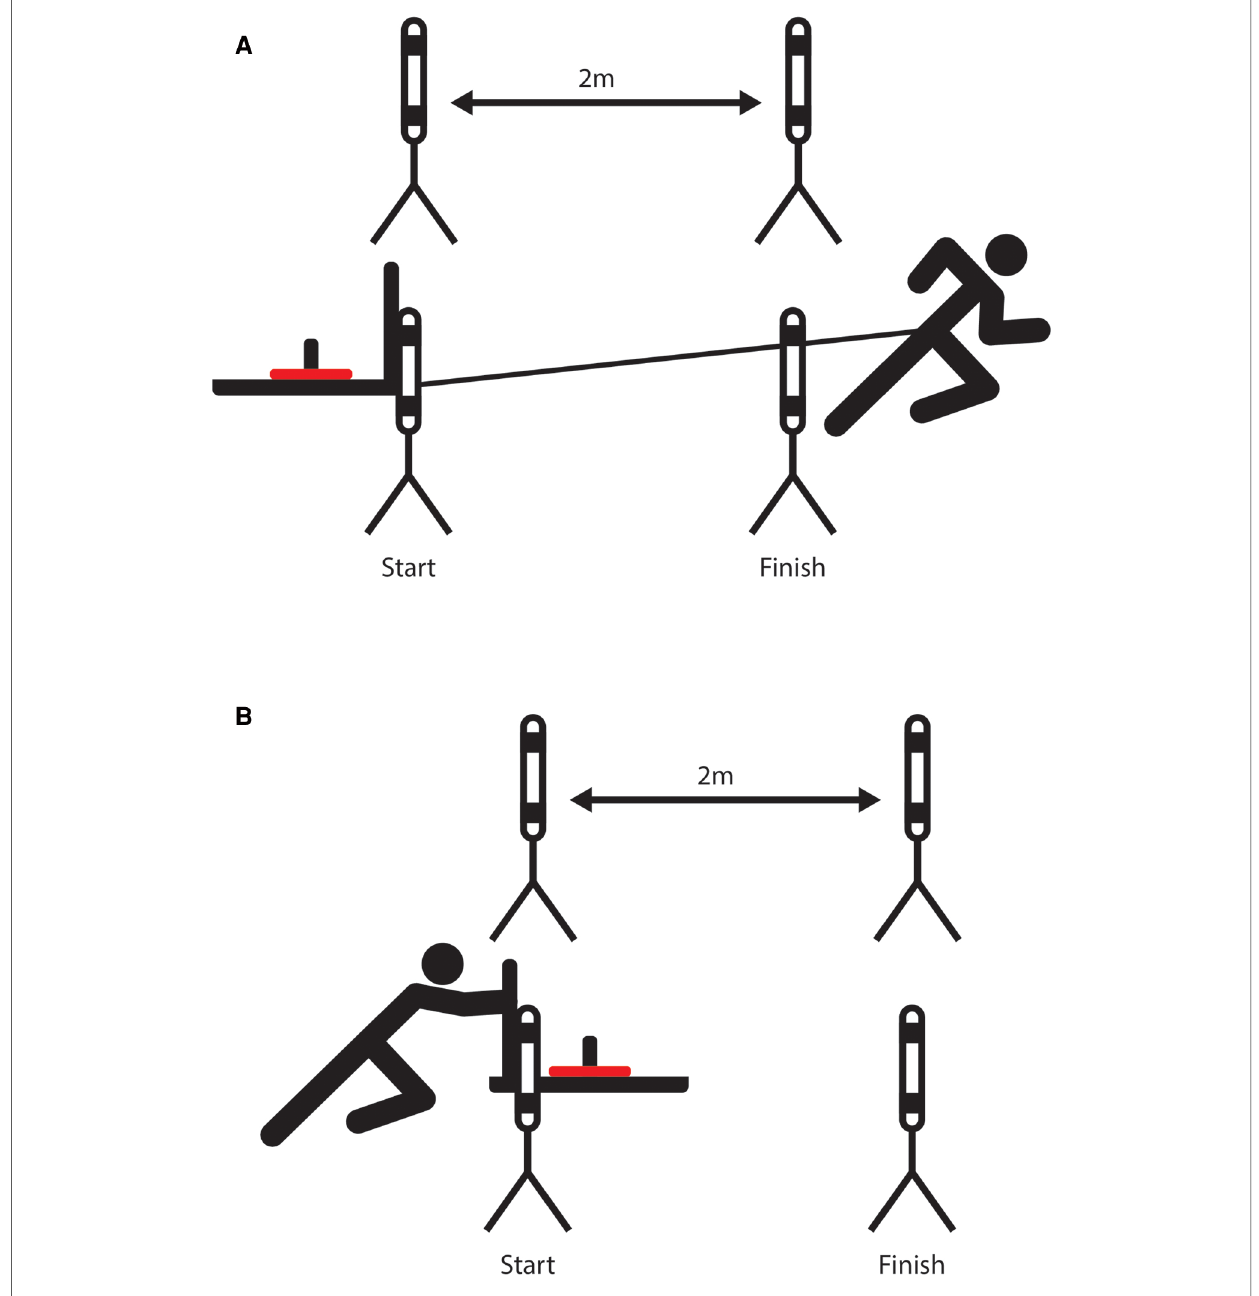
FIGURE 2 Testing set up for: ( A ) Sled pull and ( B ) Sled